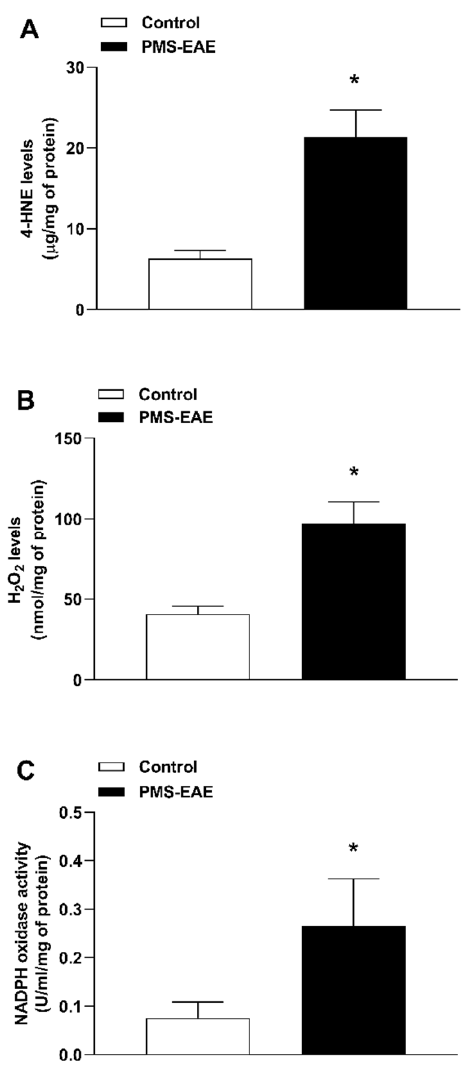
Figure 3. TRPA1 agonist levels and NADPH oxidase activity were increased in the trigeminal ganglion of the progressive multiple sclerosis model experimental autoimmune encephalomyelitis (PMS-EAE) induced-mice. Measurement of ( A ) 4-hydroxynonenal (4-HNE) and ( B ) H 2 O 2 levels, ( C ) NADPH oxidase of trigeminal ganglion samples 14 days after PMS-EAE mice induction. Data are expressed as mean + SEM ( n = 6–7). * p < 0.05, when compared to the control group parametric Student’s t -test.